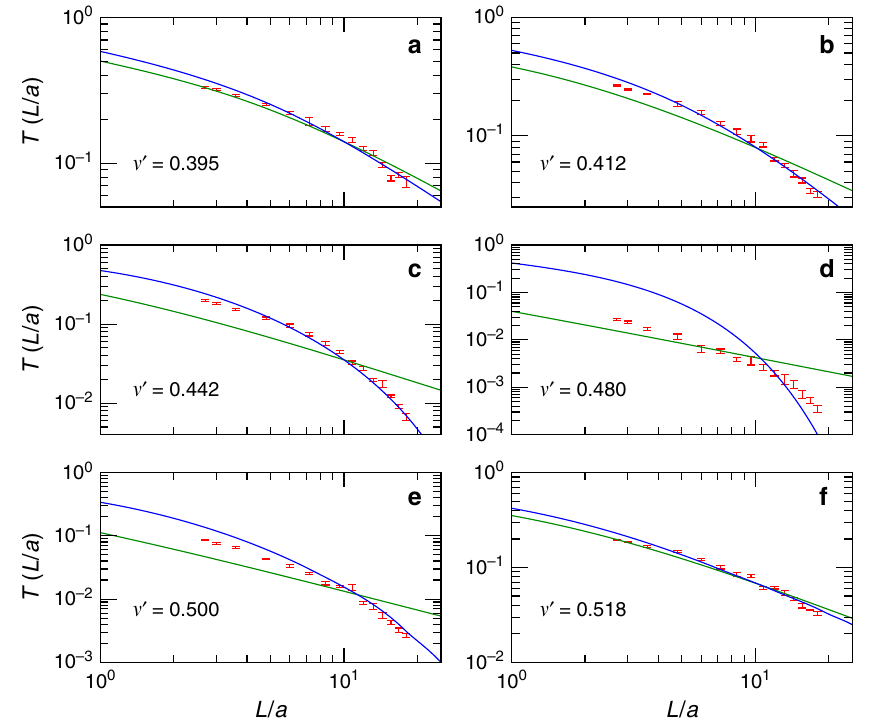
Fig. 6 Transmittance T as a function of the slab thickness. Transmittance T as a function of L / a in log – log representations for selected frequencies ( a – f ). Silicon volume fraction ϕ = 0.28. Only the averaged data for ( L / a ≥ 2.7), shown in these plots, were taken into account for fi tting. Error bars denote the standard deviation of the results obtained from 15 (thin samples) to 6 (thick samples) realizations. Blue lines: best fi t with SC theory and Eq. (1). Green lines: best fi t with Eq. (1) for ( kl ) → ∞ , in the absence of